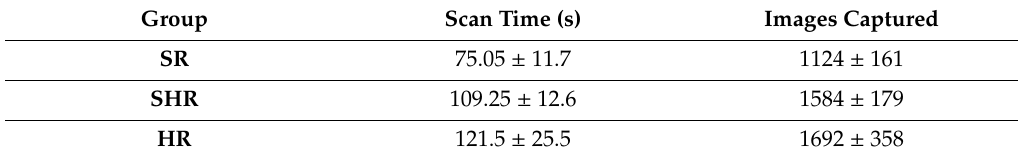
Table 1. Mean scan time (seconds) and average number of images captured per